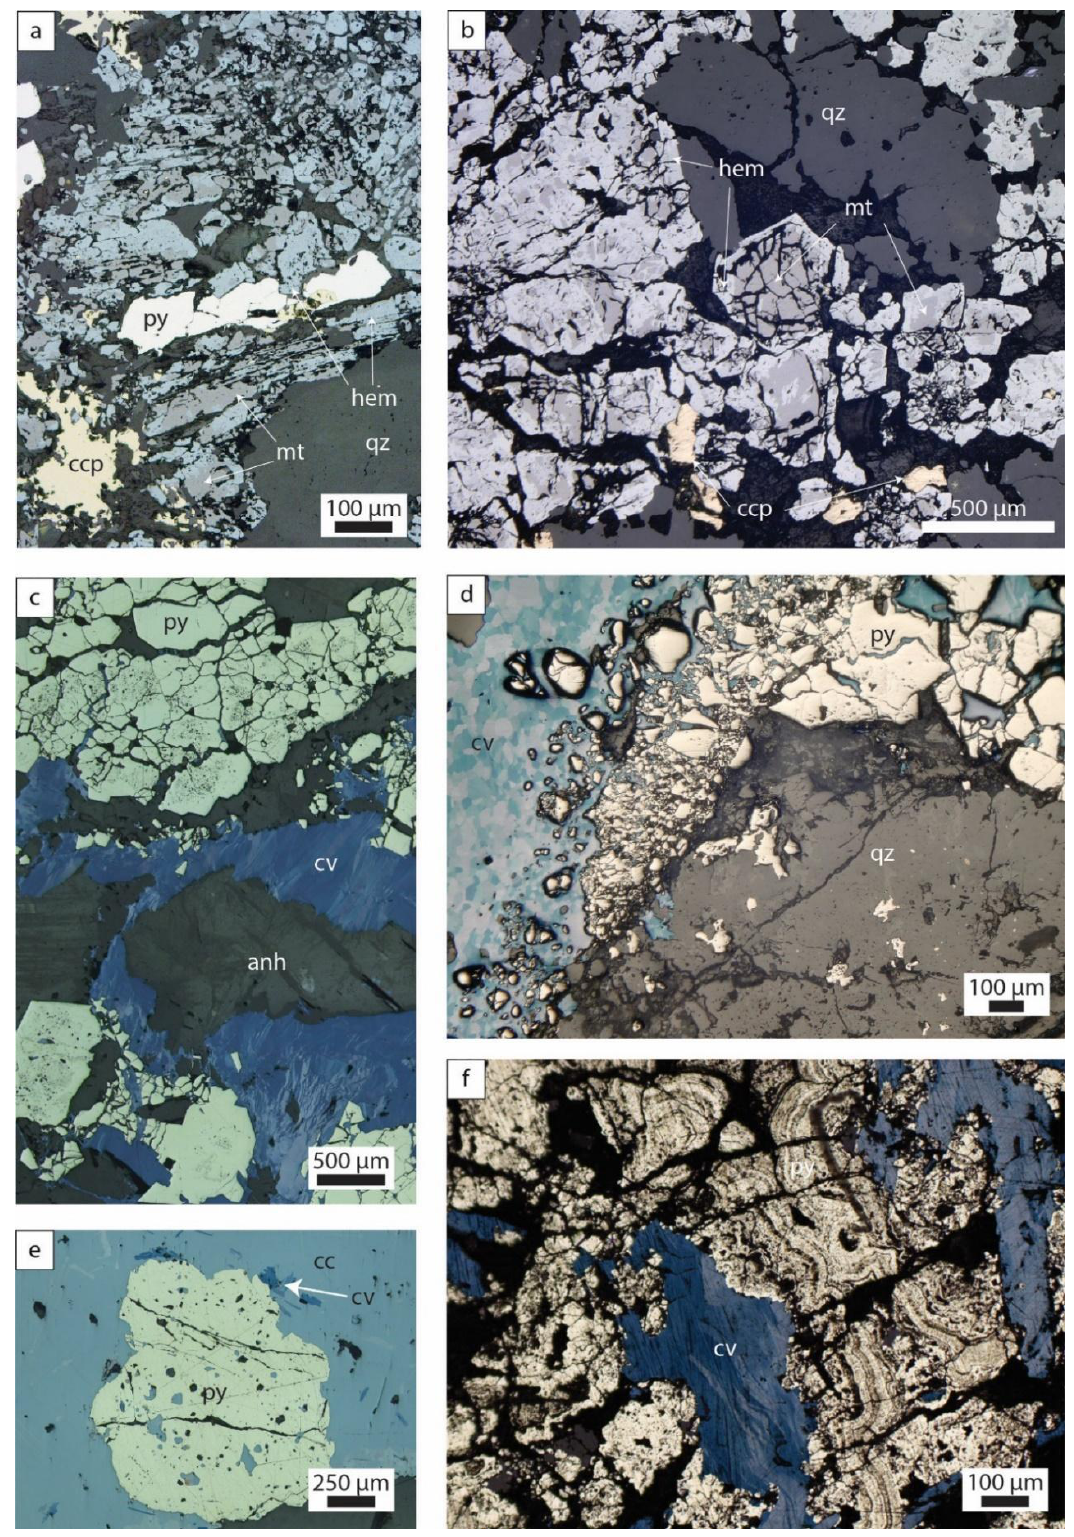
Figure 7. Ore textures from Bor and Cukaru Peki. ( a ) Deep porphyry style magnetite-chalcopyrite- pyrite-quartz veins, Bor; ( b ) magnetite-chalcopyrite-quartz vein from Cukaru Peki; ( c ) Epithermal anhydrite-sulfide veins, Bor; ( d ) Quartz-pyrite-covellite vein from transitional zone of Cukaru Peki; ( e ) Bor massive sulfide, fragmented pyrite in the matrix of chalcocite and covellite; ( f ) Collomorph pyrite overgrown by covellite, massive sulfide from Cukaru Peki.